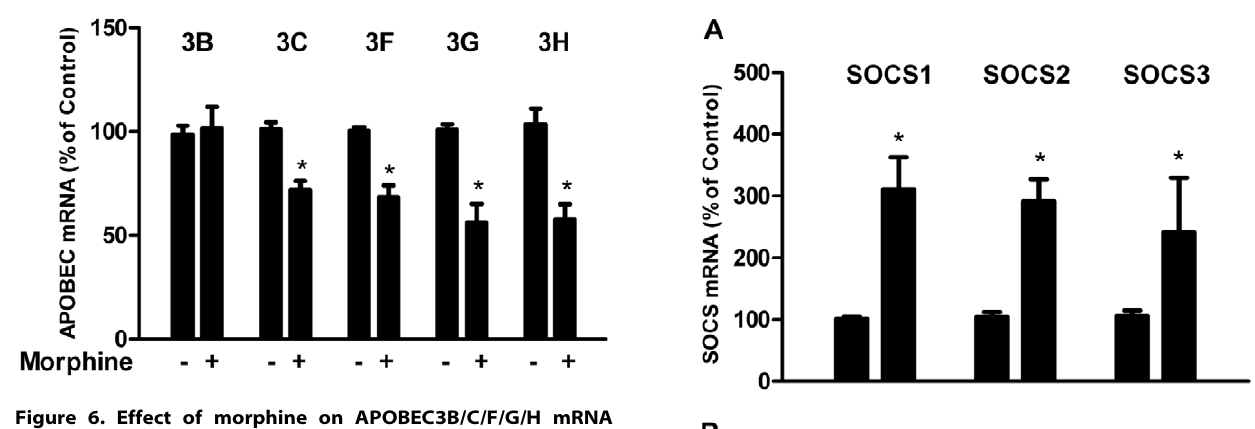
Figure 6. Effect of morphine on APOBEC3B/C/F/G/H mRNA expression. Seven-day-cultured macrophages were treated with or without morphine (10 2 10 M) for 3 h, and then cellular RNA was subjected to the real-time RT-PCR for mRNA detection. Data are expressed as mRNA levels in morphine-treated cells (percentage of control) to those in untreated cells. The results represent the mean 6 SD of three independent experiments. Statistical analysis was per- formed by Student’s t-test and significance is shown with *P , 0.05 (morphine versus control).